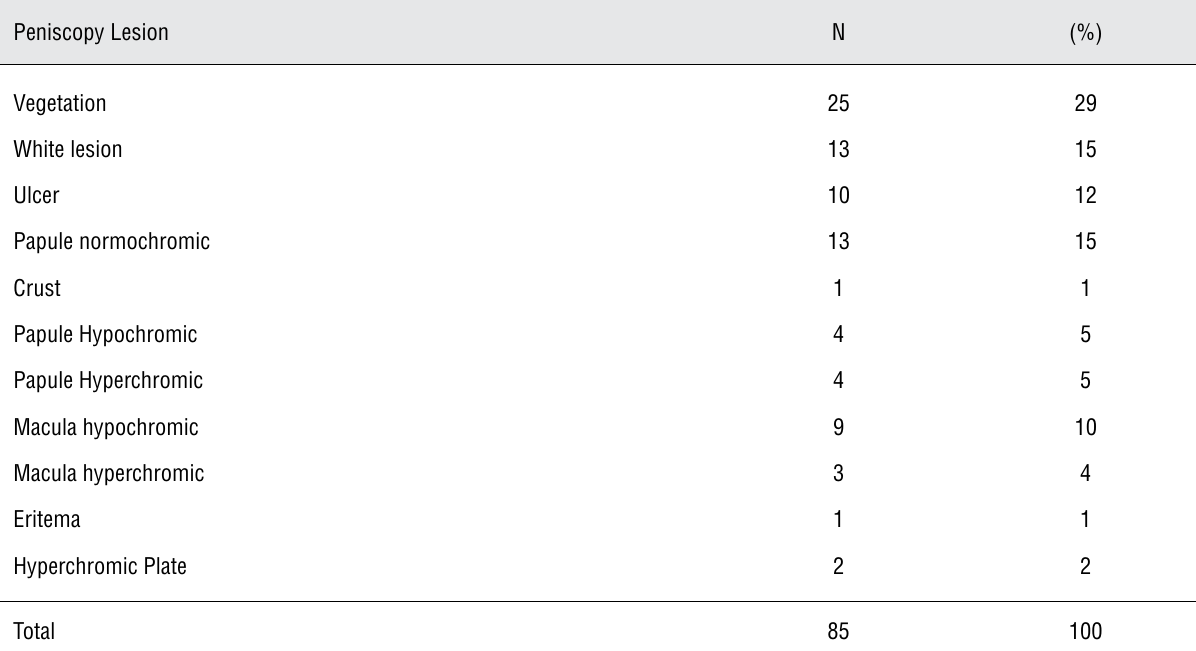
Table 4 - Distribution of dermatological lesions observed in 75 positive peniscopies. After: Rook’s 2010 (5). Peniscopy Lesion N Vegetation White lesion